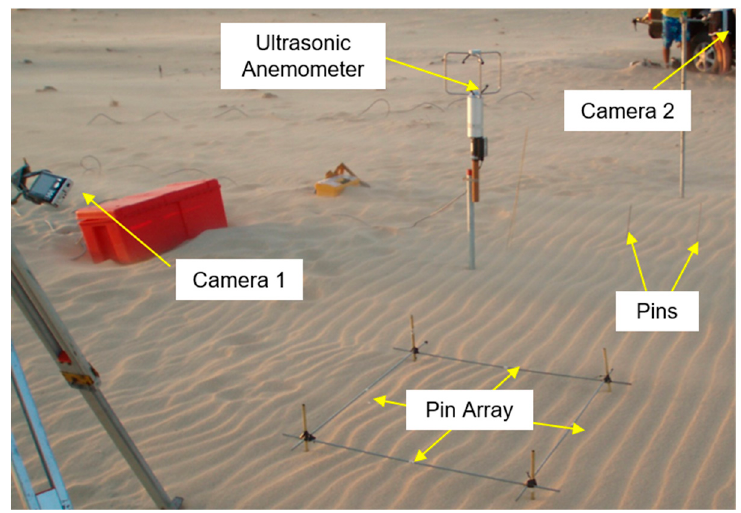
Figure 1. Basic configuration for ripple migration study at Jericoacoara, Brazil, October 2008. Wind direction was right to left. The 0.80 × 0.80 m ripple reference grid is in the center of the photograph and at center right are the 0.40-m spaced pair of reference pins.